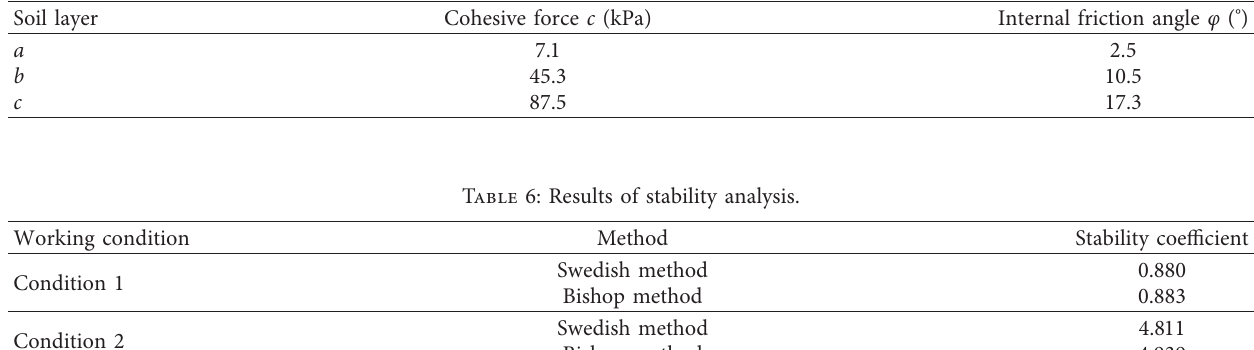
Table 5: Shear strength indexes of each layer of soil.